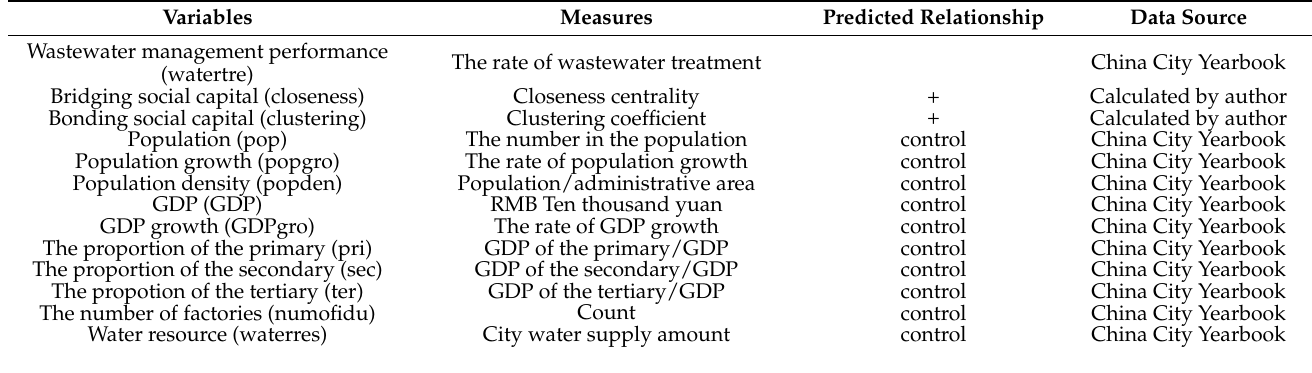
Table 1. Variables, measures, and data